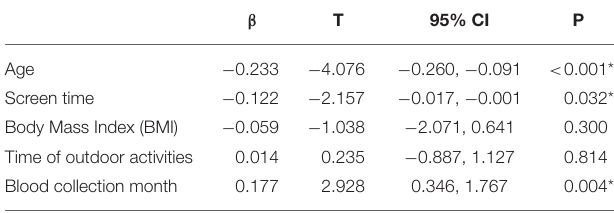
TABLE 4 | Multiple linear regression model of vitamin